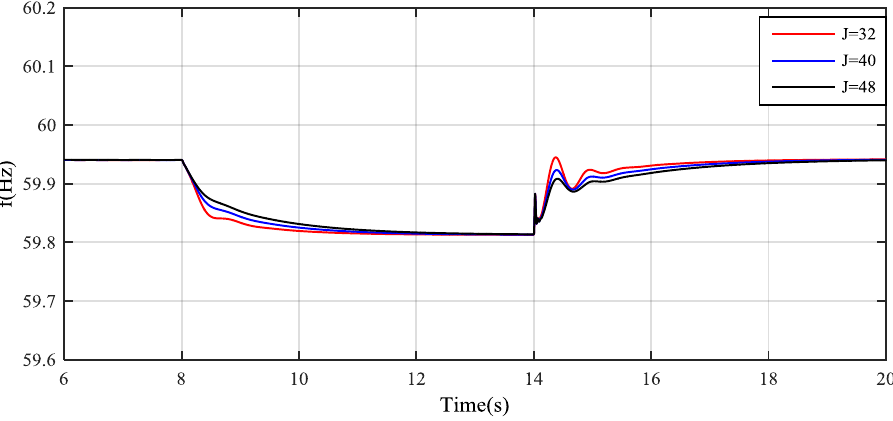
Figure 17. System frequency with different virtual inertia.